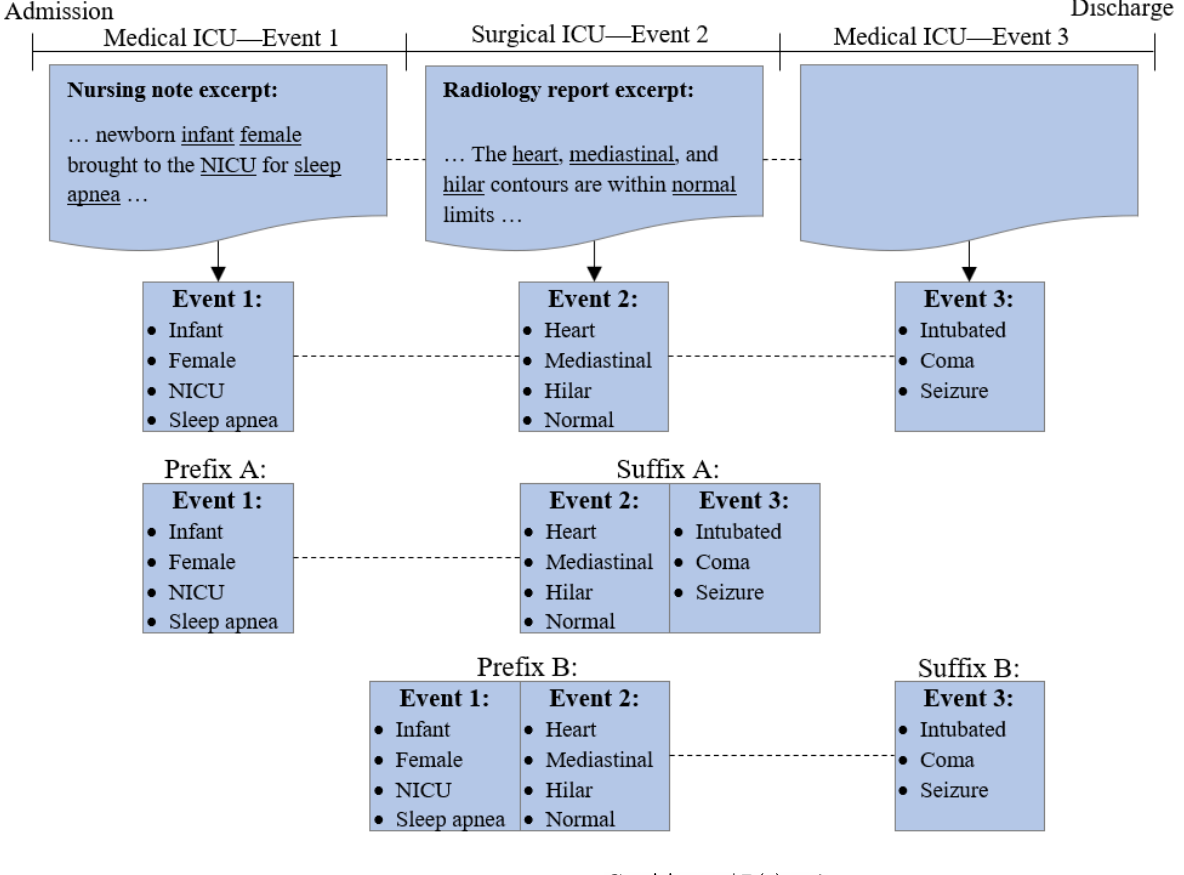
Figure 1. An example of a patient visiting the intensive care unit, discretized by ward transfers. In this example, the patient was admitted to the medical intensive care unit, transported to radiology, and transferred to the surgical intensive care unit. As this example contains 3 events, there are 2 possible